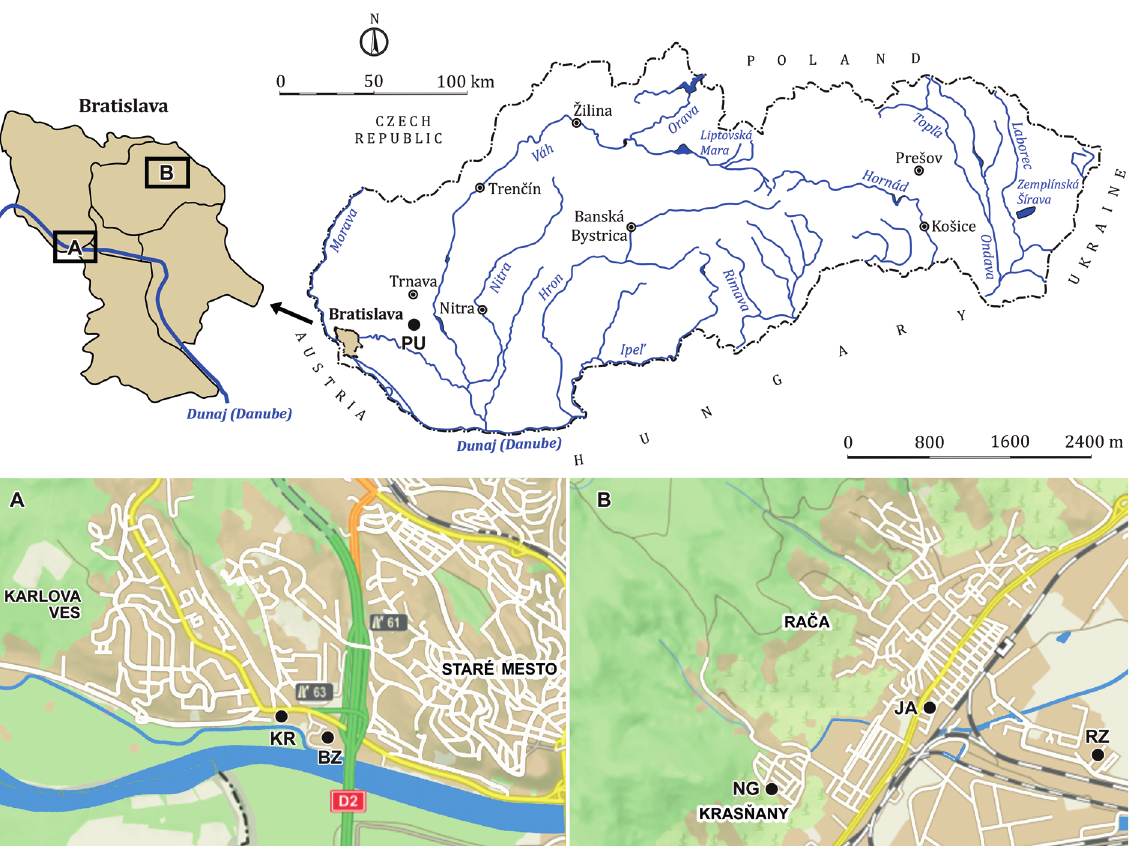
Fig. 1. Map of Slovakia showing the localization of six collection sites (marked by black dots). A schematized outline of Bratislava City is depicted left of the map of Slovakia. Rectangles A and B indicate the two Bratislava study areas, whose details are shown in panels (A) and (B) under the map of Slovakia. For locality codes and further details, see Table